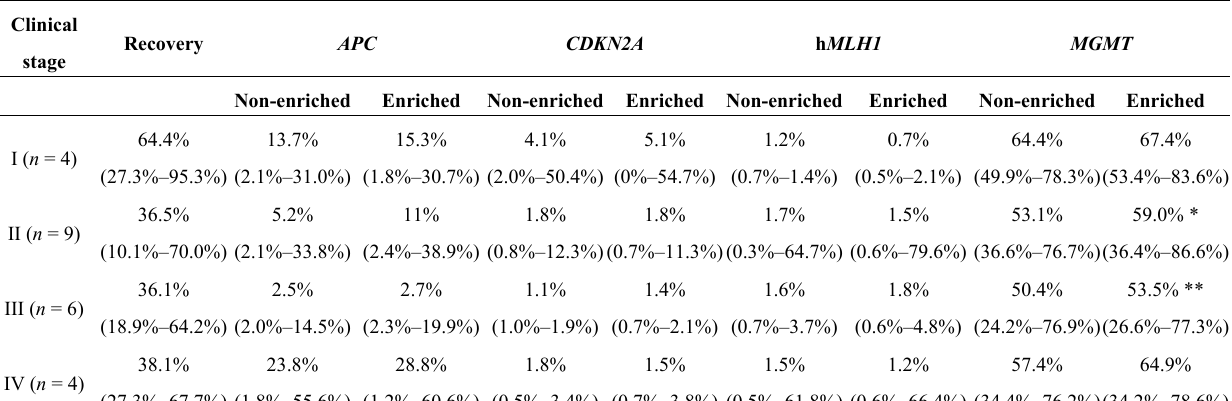
Table 2. DNA methylation in whole tumor cell suspension (non-enriched) and in epithelial cell adhesion molecule (EpCAM)+ (tumor) cells (enriched). Cell recovery: Percentage of the EpCAM (CD326)+ cell number obtained from immunomagnetic selection divided by total number of cells in the tumor cell suspension before immunomagnetic